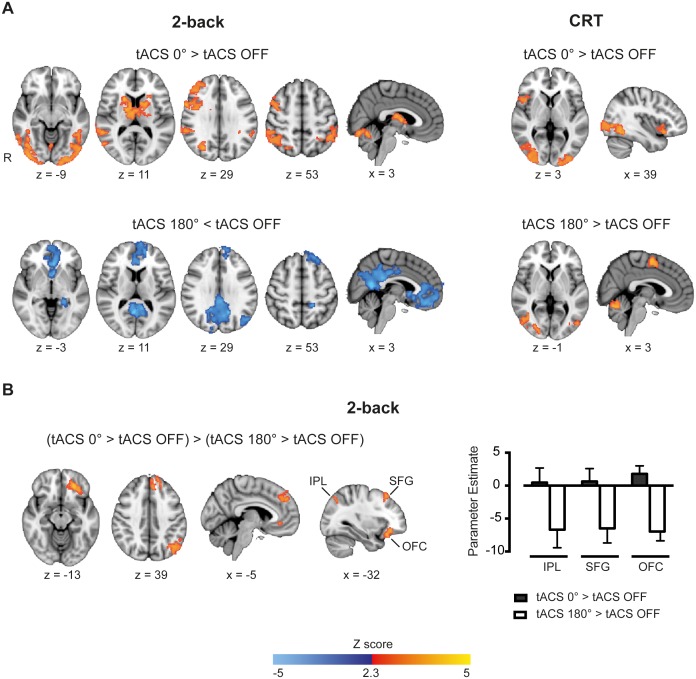
Whole-brain patterns elicited by synchronous and desynchronous tACS conditions.(A) Synchronous tACS during the 2-back task increased BOLD signal in brain regions underneath the parietal, IPL-electrode (inferior parietal lobule), and frontal, MFG-electrode (medial frontal gyrus), electrodes (n = 21). (B) During the 2-back task synchronous tACS showed significantly greater activity than tACS OFF in the right frontoparietal network and regions normally activated by task performance. Desynchronous tACS resulted in decreased activation compared to tACS OFF in default mode network regions. TACS applied during the CRT task resulted in greater activity in occipito-temporal regions for both synchronous and desynchronous tACS conditions. (C) Increased BOLD signal for synchronous compared to desynchronous tACS conditions, for tACS stimulation relative to no tACS stimulation, was observed in the left hemisphere in the inferior parietal lobule (IPL), superior frontal gyrus (SFG) and orbitofrontal cortex (OFC). This difference in brain activity is explained by decreased activity during desynchronous compared to synchronous tACS, right plot. Images are in the Montreal Neurological Institute (MNI) space coordinates and in radiological space. R=right hemisphere. All images have been thresholded with FSL clusterwise correction Z > 2.3, p<0.05.DOI:
http://dx.doi.org/10.7554/eLife.22001.01110.7554/eLife.22001.012Figure 4—source data 1.This folder contains the MRI contrast maps in Figure 4, both thresholded (that is, corrected for multiple comparison using cluster correction) and non-thresholded.The maps are in NIfTI format and can be opened with freely available data viewers such as FSLView or MRIcron.DOI:
http://dx.doi.org/10.7554/eLife.22001.01210.7554/eLife.22001.013Figure 4—source data 2.This folder contains the MRI contrast maps in Figure 4—figure supplement 1, both thresholded (that is, corrected for multiple comparison using cluster correction) and non-thresholded.The maps are in NIfTI format and can be opened with freely available data viewers such as FSLView or MRIcron.DOI:
http://dx.doi.org/10.7554/eLife.22001.01310.7554/eLife.22001.014Figure 4—source data 3.This table contains the parameter estimates for each subject in the bar plot in Figure 4B.